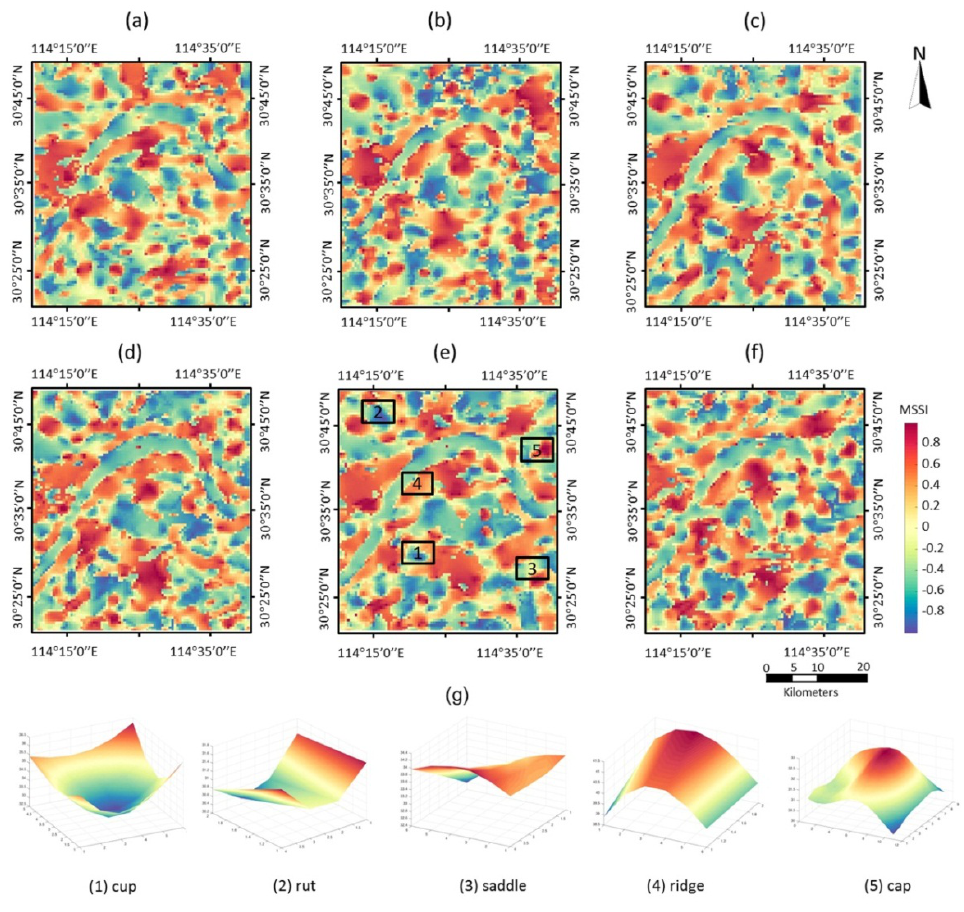
Figure 7. The Multi-Scale Shape Indexes (MSSIs) of the 6 years indicating the surface morphology of LLSTs. The MSSI of ( a ) 2002, ( b ) 2005, ( c ) 2007, ( d ) 2011, ( e ) 2014, ( f ) 2017, ( g ) the classic morphologies taken from the MSSI of 2014.